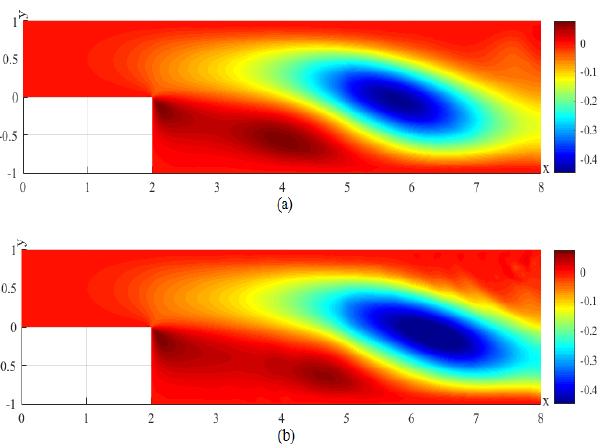
Figure 15. ( a ) The CNMFE solution for v at t = 10. ( b ) The RDRCNMFE solution for v at t = 10.